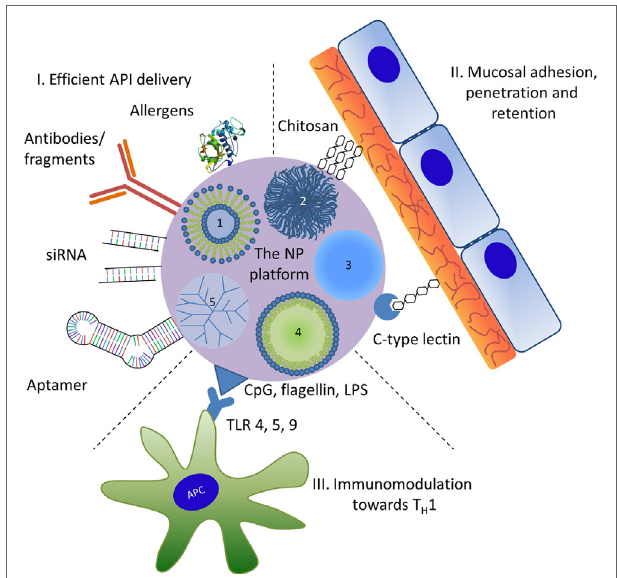
FiGURe 1 | nanoparticles (nPs) used as a potential multifunctional nanomedical platform to facilitate three roles in therapeutic use . The numbers represent different types of NPs: 1, liposomes; 2, biopolymers; 3, inorganic NPs; 4, nanoemulsions; 5, dendrimers. Active pharmaceutical ingredient (API); for symbolizing protein APIs the 3D structure of Der p 1, the major house dust mite allergen (PDB entry 3f5v) was used; LPS, lipopolysaccharide; TLR, Toll-like receptor; T H 1, T helper 1